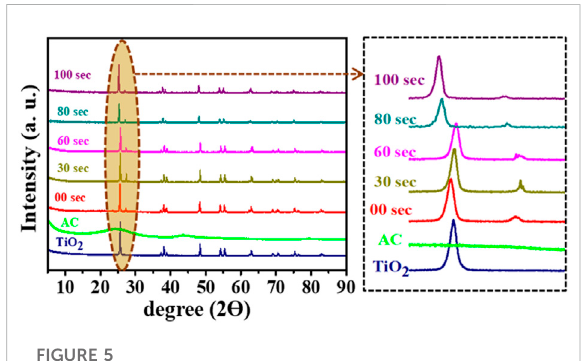
FIGURE 5 Recorded XRD graphs for untreated and microwave plasma treated